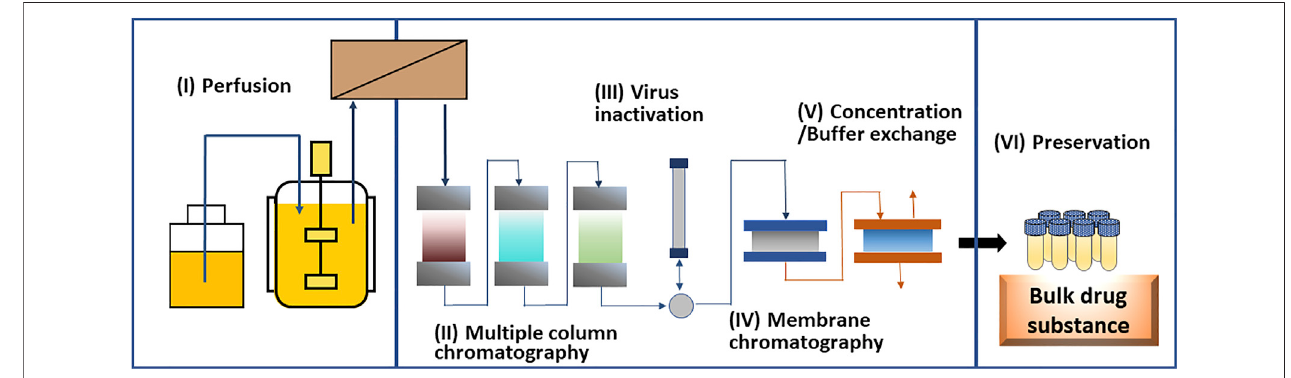
FIGURE 3 | Schematic drawing of an example of end-to-end continuous manufacturing process for therapeutic monoclonal